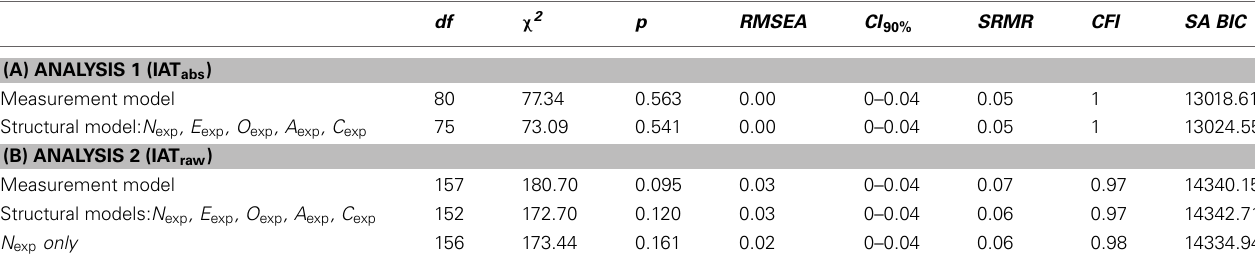
Table 2 | Model fit